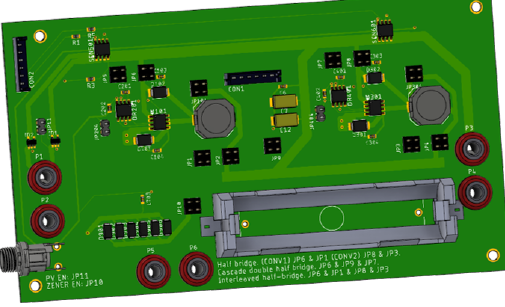
Figure 5. Fabricated prototype